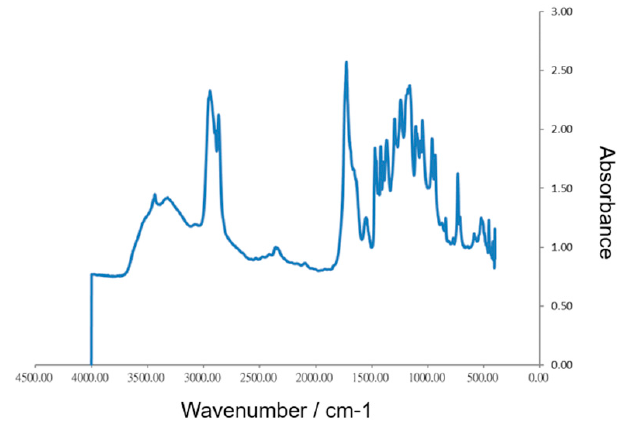
Figure 2. FTIR spectra of collagen scaffold.